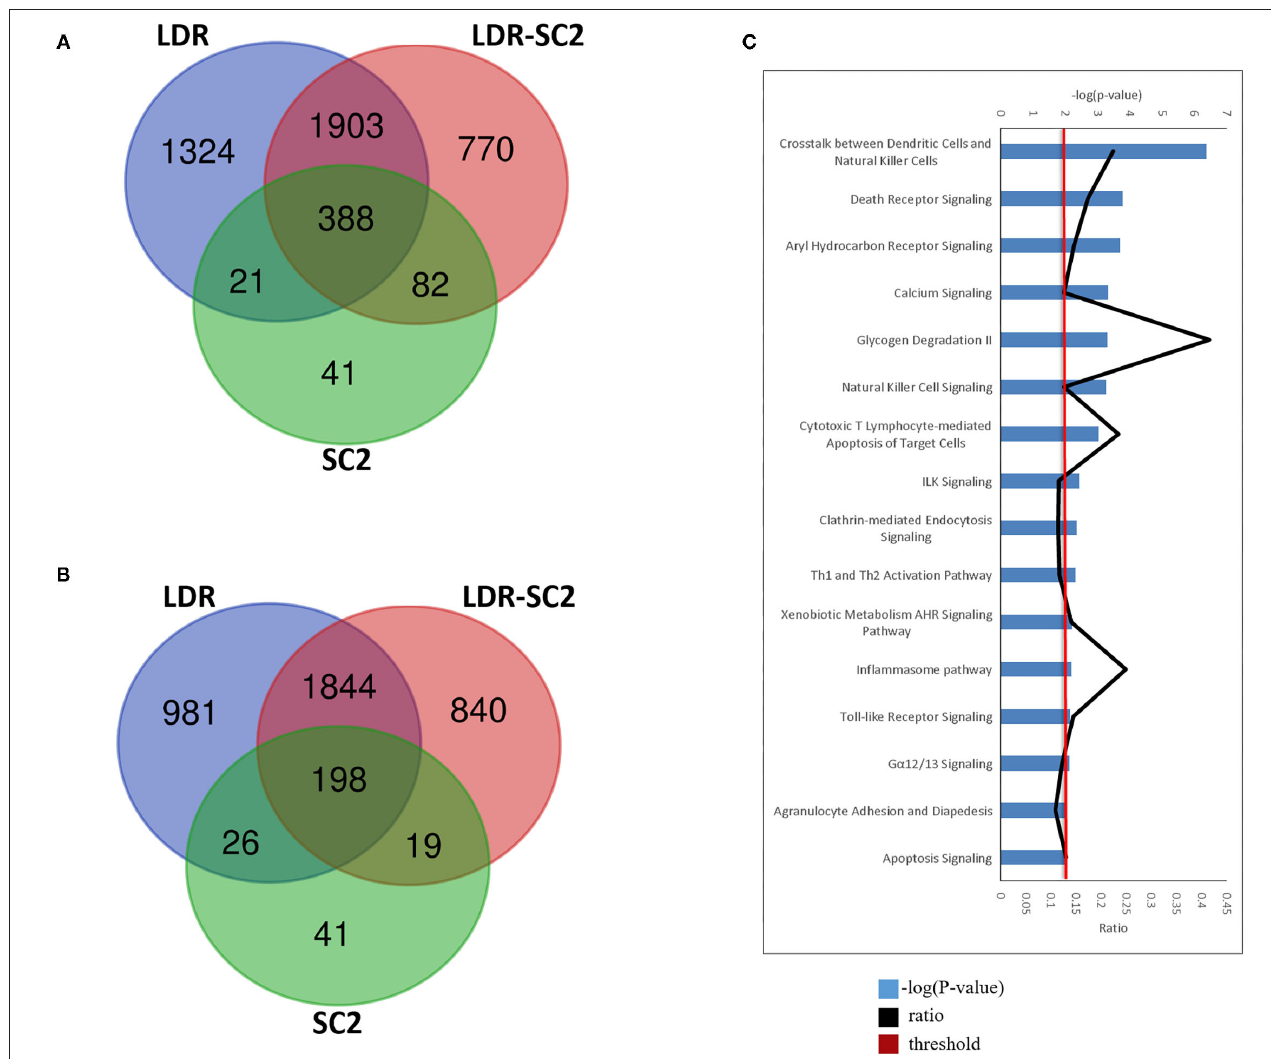
FIGURE 7 | LDR-SC2 unique DEGs and Canonical pathways. (A,B) Venn diagram showing the distribution of differentially-expressed genes that are unique or common among the three treatments. (A) upregulated DEGs. (B) downregulated DEGs. (C) Top canonical pathways derived from Ingenuity pathway analysis. The canonical pathways are analyzed with both up and down-regulated genes ( p ≤ 0.01) and ranked according to their –log ( P -value) (blue bars). “Threshold” (red line) indicates the minimum significance level (scored as –log [ P- value] set here at 2.5). “Ratio” (black curve) indicates the number of molecules from the data set that map to the pathway listed divided by the total number of molecules that map to the canonical pathway from within the IPA